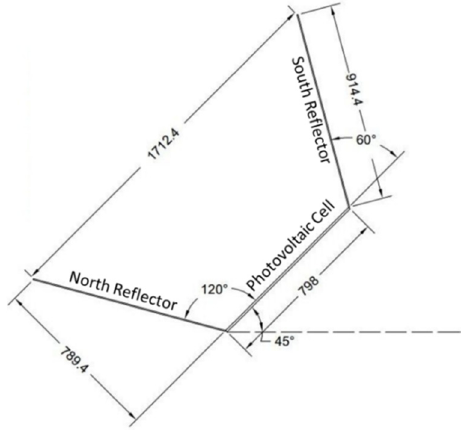
Figure 6. Dimensions (mm) of V-trough PV System.